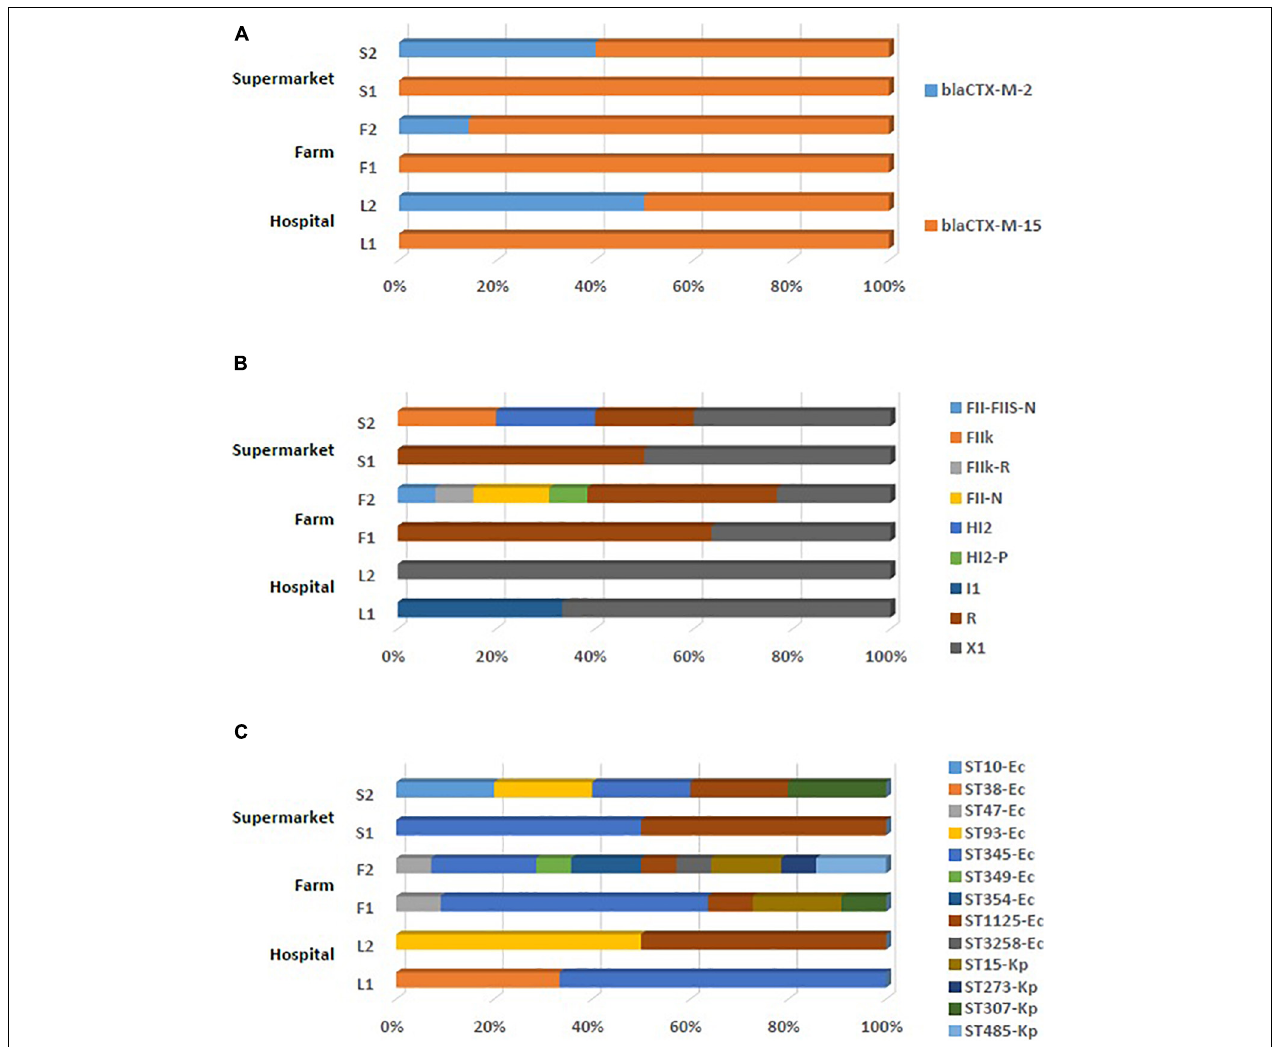
FIGURE 1 | Distribution of ESBL gene types (A) , plasmid replicon types (B) , and isolate sequence types (C) among the ESBL-producing isolates recovered from each of the reservoirs tested. Refer to Table 1 for the more detailed molecular characteristics of each isolate